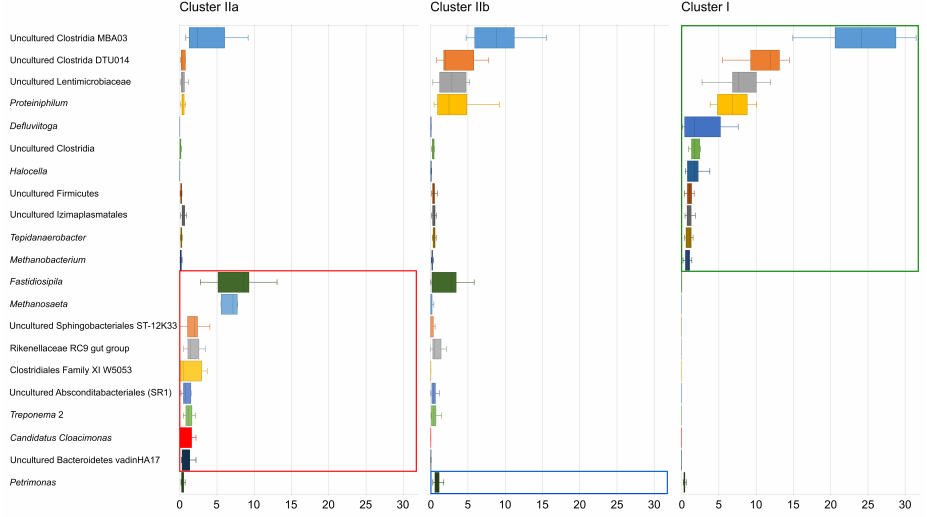
Figure 5. Exemplary distribution of the 21 most abundant indicative taxa and their relative abun- dances within the defined clusters IIa, IIb, I based on the taxonomic profiles. Indicator taxa of the respective clusters are boxed in red for cluster IIa, blue for cluster IIb and green for cluster I. Statistically significant differences were calculated using the “indicspecies” package of R with a point biserial correlation coefficient as statistic value